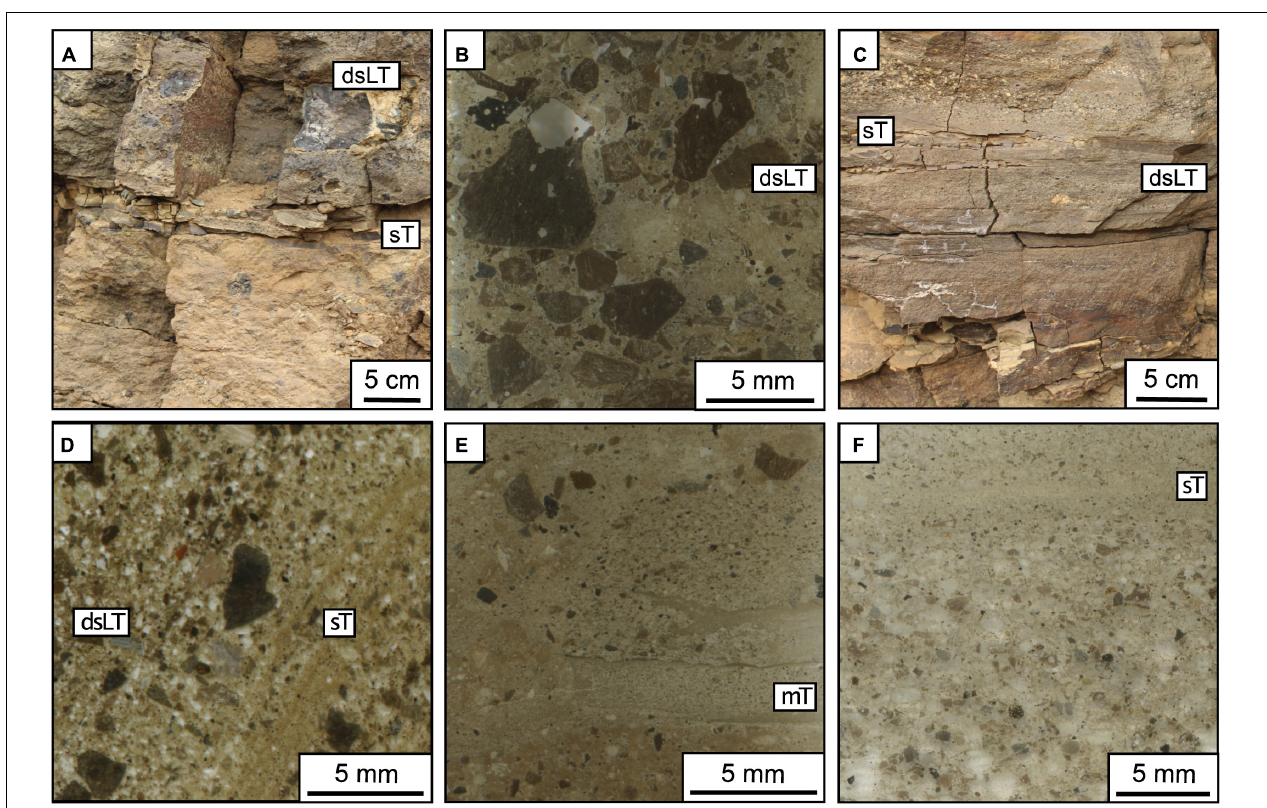
FIGURE 7 | Photographs of the finer grained facies of the tuffisite. Labels give the facies present in each image and are also listed in brackets. (A) Thinly bedded medium grained lapilli-tuff horizons of finer material (Facies dsLT) above large ignimbrite clasts. (B) Thin section of a poorly sorted coarse lapilli-tuff showing some alignment of grains (Facies dsLT). (C) Finely laminated and cross-stratified tuff (Facies sT) with thinly bedded medium grained lapilli-tuff beneath (Facies dsLT). (D) Thin section of fine grained lapilli-tuff showing grain alignment (Facies dsLT), and finer horizons of ash-sized material (Facies sT). (E) Thin section containing a discontinuous veinlet of massive fine material that coarsens toward the centre (Facies mT). (F) Coarse lapilli-tuff fining upwards into Facies